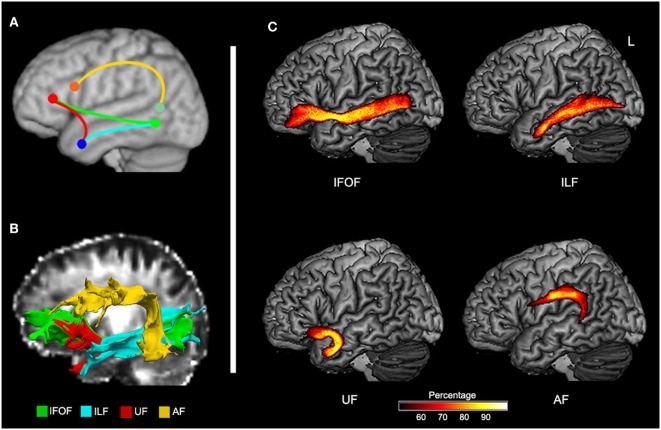
Probabilistic maps of reconstructed ventral and dorsal pathways related to language. (A) Schematic representation of expected tracts in Montreal Neurological Institute space. (B) Reconstructed inferior fronto-occipital fasciculus (IFOF), inferior longitudinal fasciculus (ILF), uncinate fasciculus (UF), and arcuate fasciculus (AF) in native space of a control subject. (C) Group-based probability maps of IFOF, ILF, UF, and AF derived from probabilistic tractography in healthy older subjects (at least 50% subjects of each voxel).